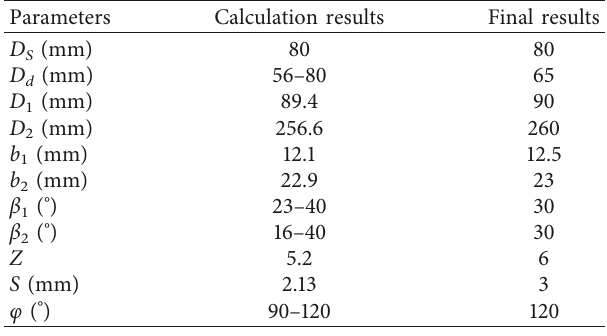
Table 1: The main structural parameters of